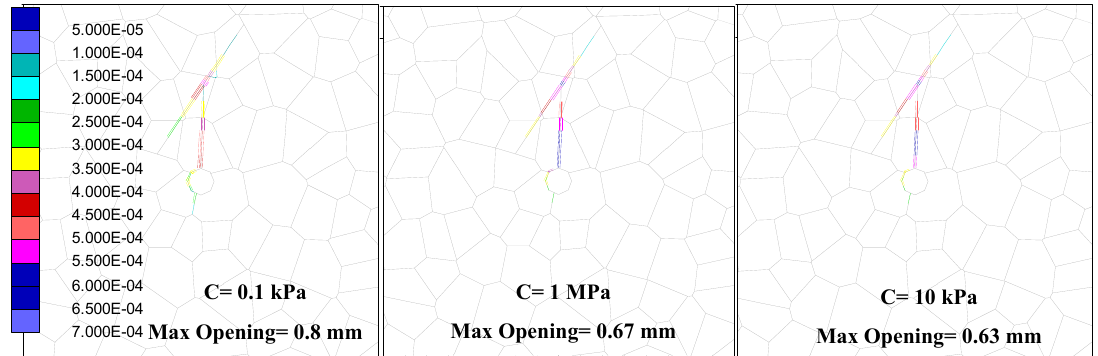
Figure 10. E ff ect of cohesion strength of NF on the HF propagation (approach angle of 33 ◦ and ∆ σ of Figure 10. Effect of cohesion strength of NF on the HF propagation (approach angle of 33 degrees and 232 10 MPa). Δσ of 10 MPa) 233